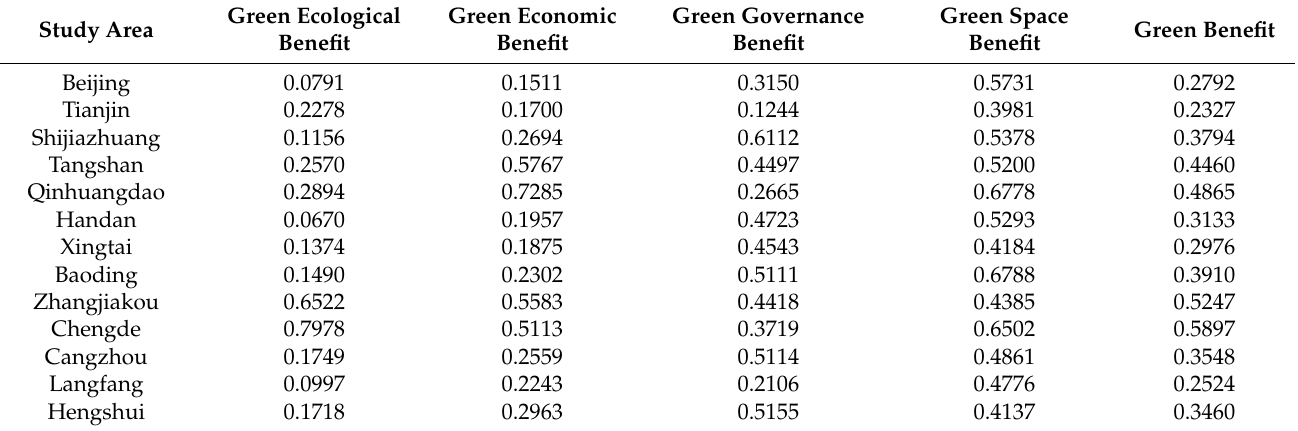
Table 2. Green benefit index of land use in the Beijing–Tianjin–Hebei